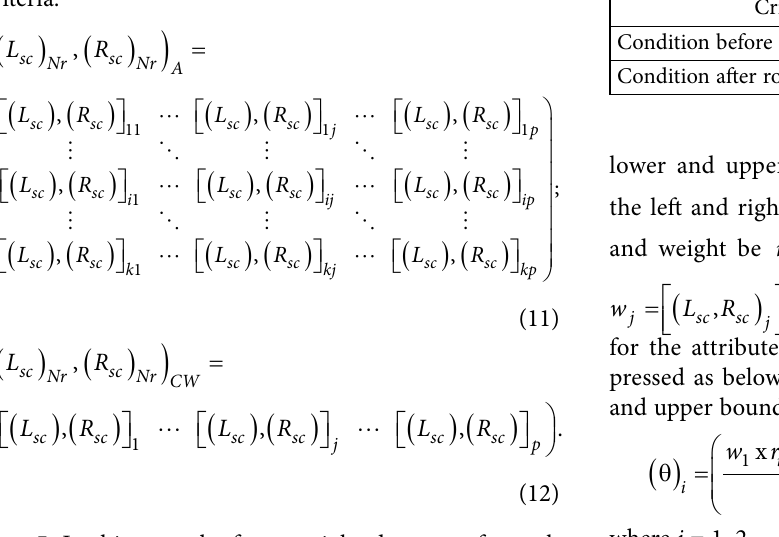
Table 10. Left and right interval ratings for the